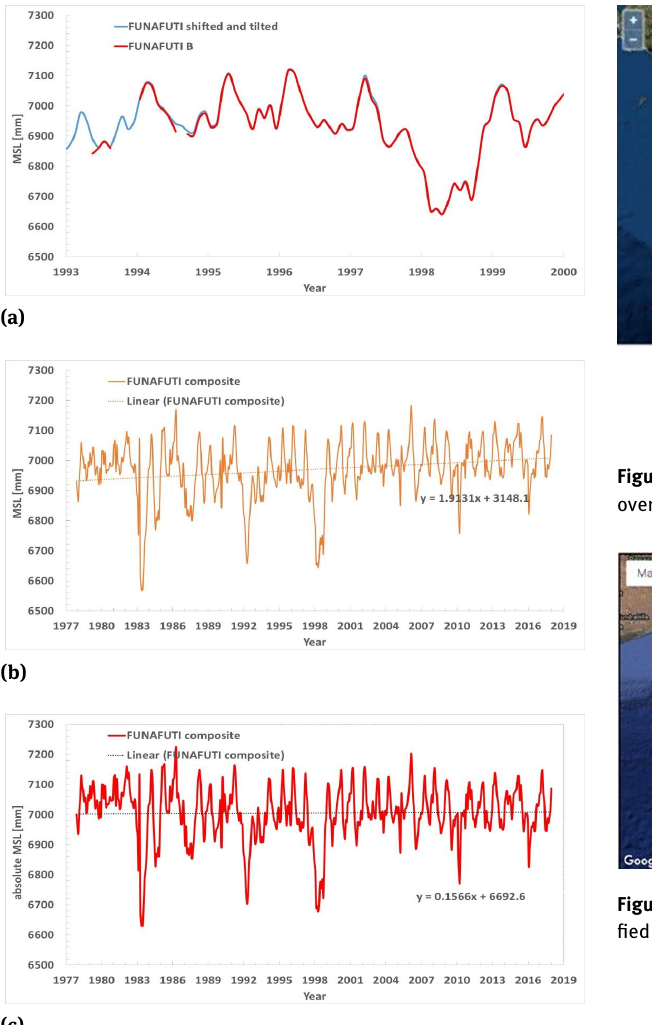
Figure 14: Absolute and relative sea level in Funafuti 1977 to present; (a) relative sea level from the two tide gauges over the time window 1993 to 2000; (b) the relative sea level of the composite tide gauge record over the time window 1977 to 2018; (c) absolute sea level of the composite tide gauge record over the time window 1977 to 2018.